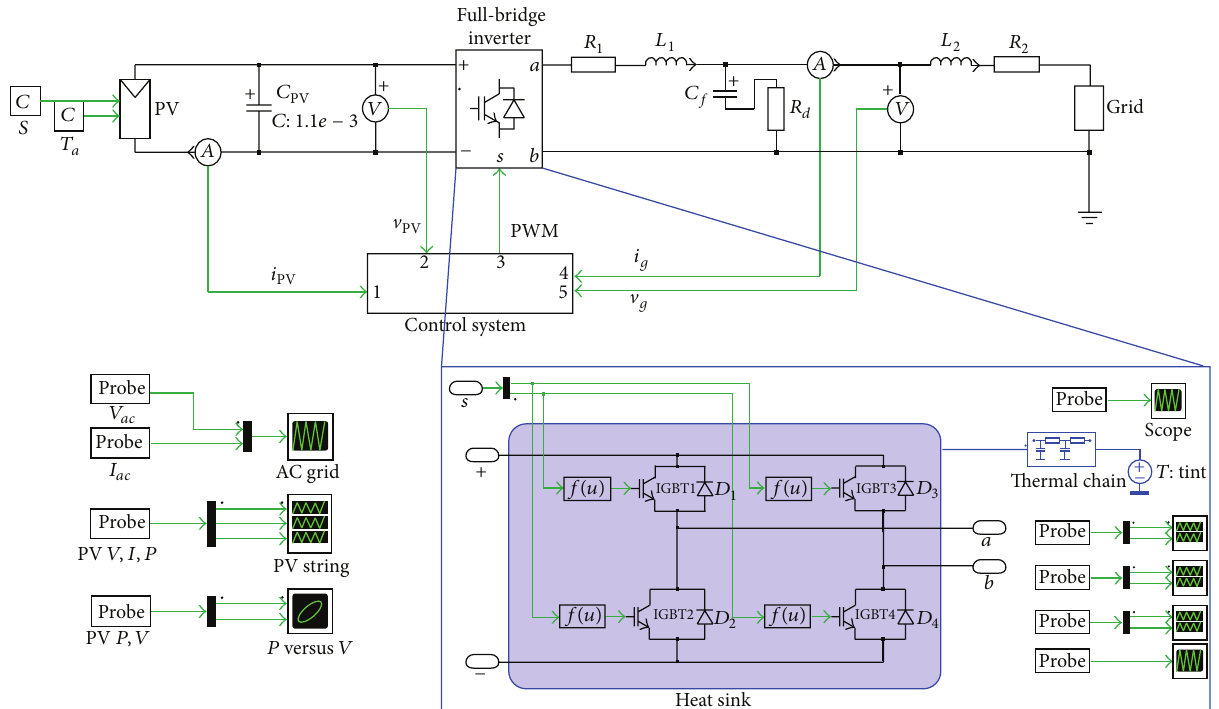
Figure 7: Simulation model of a single-phase full-bridge PV inverter system in PLECS.